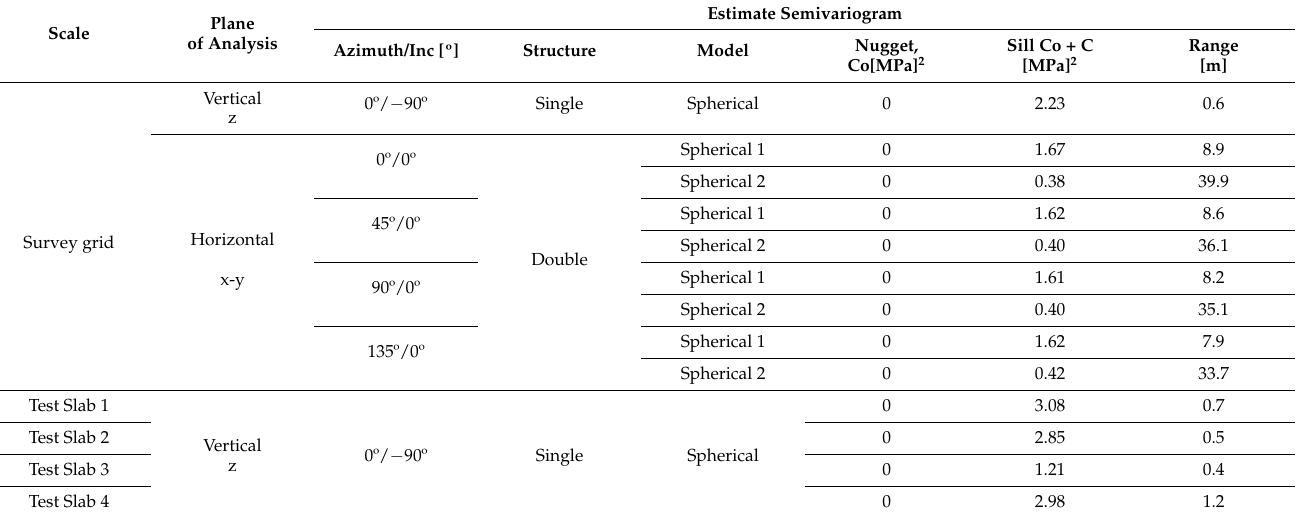
Figure 7. Experimental semivariograms and theoretical models for q d . Vertical analysis plane. Table 9. Experimental results for vertical and horizontal semivariograms of q d based on the full survey grid and test